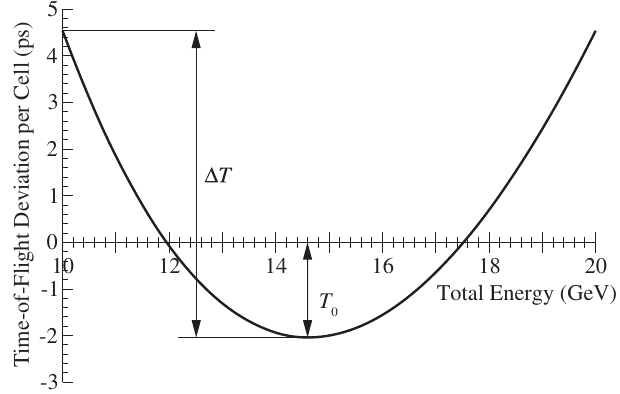
FIG. 1. Time of flight as a function of energy in a